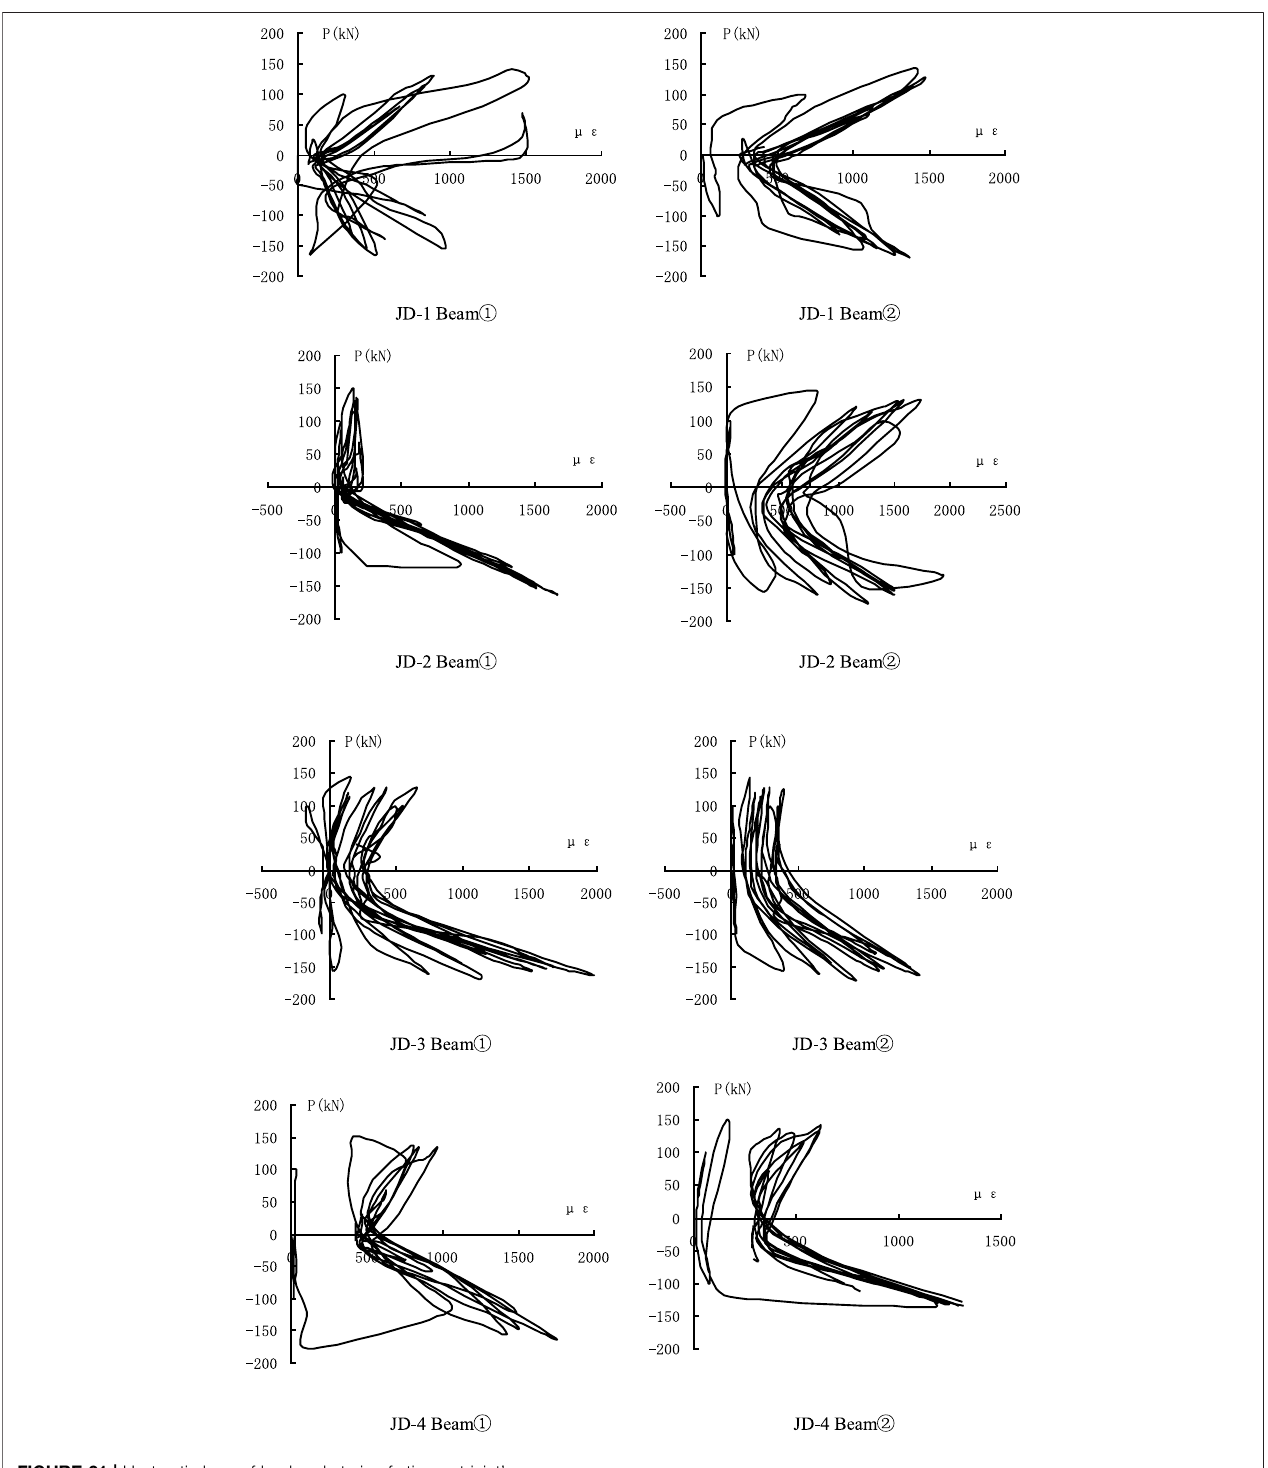
FIGURE 21 | Hysteretic loop of load and strain of stirrup at joint ’ s core.